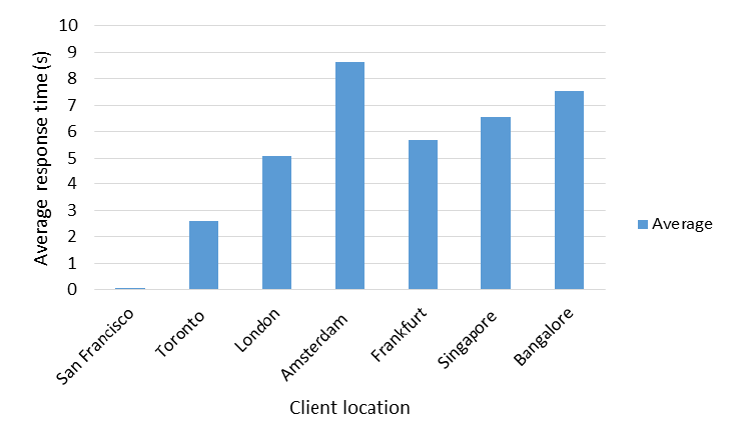
Figure 11. Average response times according to client location.